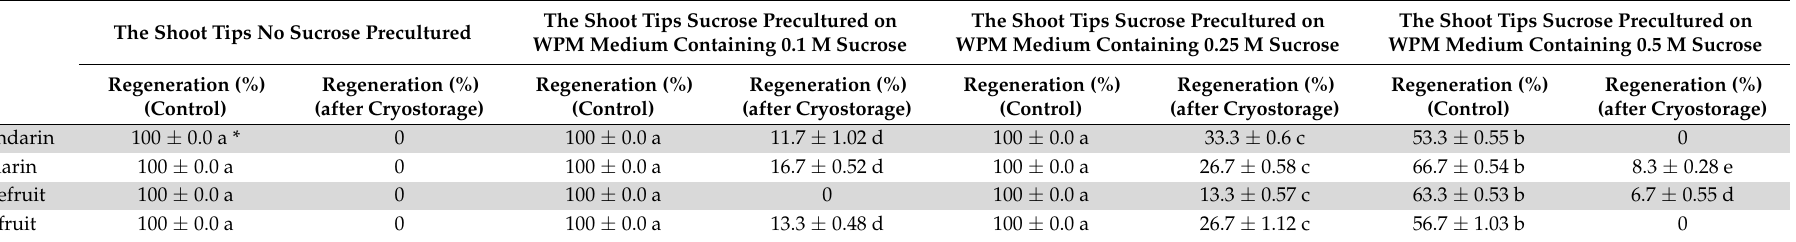
Table 4. The shoot tip regeneration of four different Citrus spp. cultivars tested in different sucrose preculture media for 24 h. The shoot tips treated with PVS2 for 45 min were incubated in regeneration medium for the first 24 h, and then they transferred to WPM medium supplemented with 1 mg.L − 1 BAP, 10 mg.L − 1 activated charcoal, and 1 mg.L − 1 H 3 BO 3 medium for four weeks under standard culture